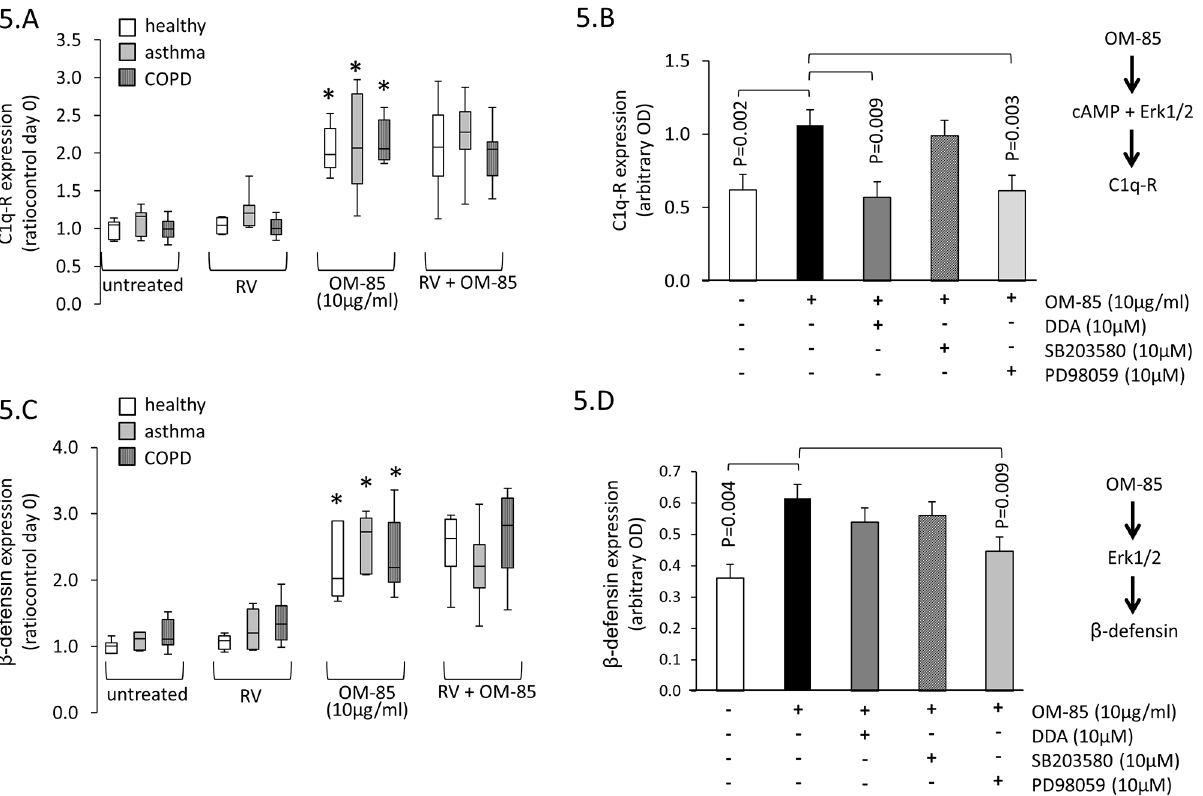
Fig 5. Differential regulation of cell surfaceRV binding proteins by OM-85 and RV infection. (A) Expression of C1q-R after 48 hrs incubationwith OM-85 (10 μ g/ml). Box-plots represent median and 95% confidence interval for BEC derived from: non-asthma, non-COPD controls (n = 6), asthma (n = 10) and for COPD (n = 7). (B) shows the effect of cell signal inhibitors(DDA for cAMP; SB203580for p38 MAPK and PD98059for Erk1/2 MAPK) on C1q-R expressioninducedby OM-85. The analysiswas performed in 5 BEC lines across all three patient groups. (C) Expression of β -defensinafter 48 hrs incubationwith OM-85 (10 μ g/ml). Box-plots represent median and 95% confidence interval determined in BEC of non-asthma, non-COPD controls (n = 6), asthma (n = 10), and COPD (n = 7). (D) shows the effect of cell